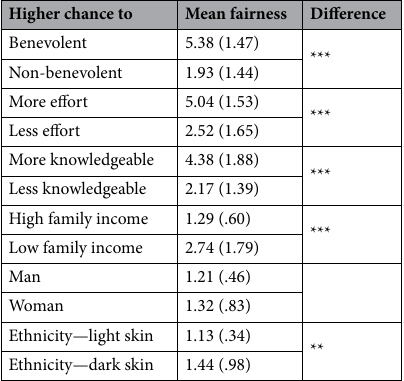
Table 3. Asymmetries and Wilcoxon signed-rank test comparisons. Notes: Standard deviations are indicated in parentheses. Stars in a cell indicate a significant difference in fairness for a factor depending on who is advantaged. Holm-Bonferroni-corrected p -values: * p < .05 ; ** p < .01 ; *** p < .001 .